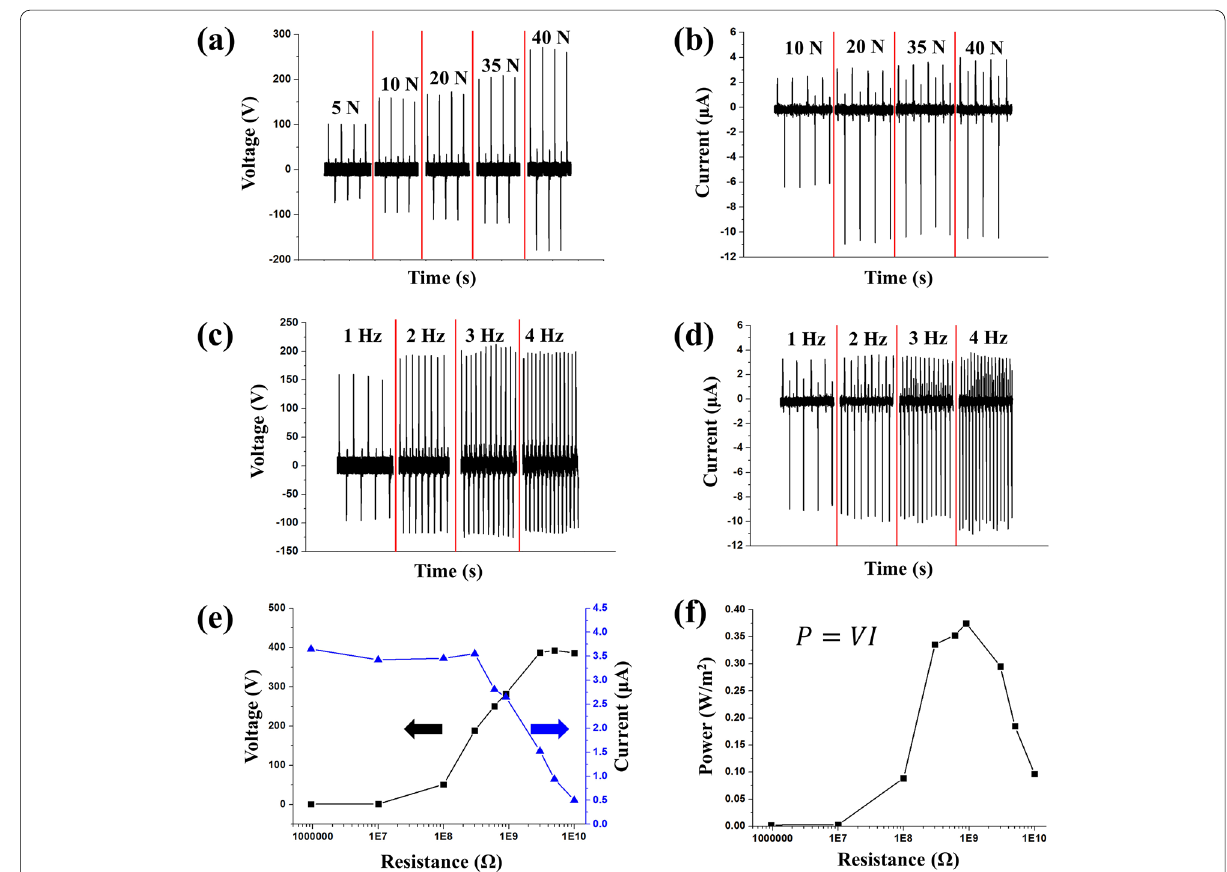
Fig. 2 Electrical output performance of the T‑TENG using 500 MΩ. a Open‑circuit voltage and b Short‑circuit current of the T‑TENG at varying pressure at frequency of 1 Hz. c Open‑circuit voltage and d Short‑circuit current of the T‑TENG at varying frequency at pressure of 15 N. ( e ) Output voltage, current, and f Instantaneous power density of the T‑TENG at varying external load resistances